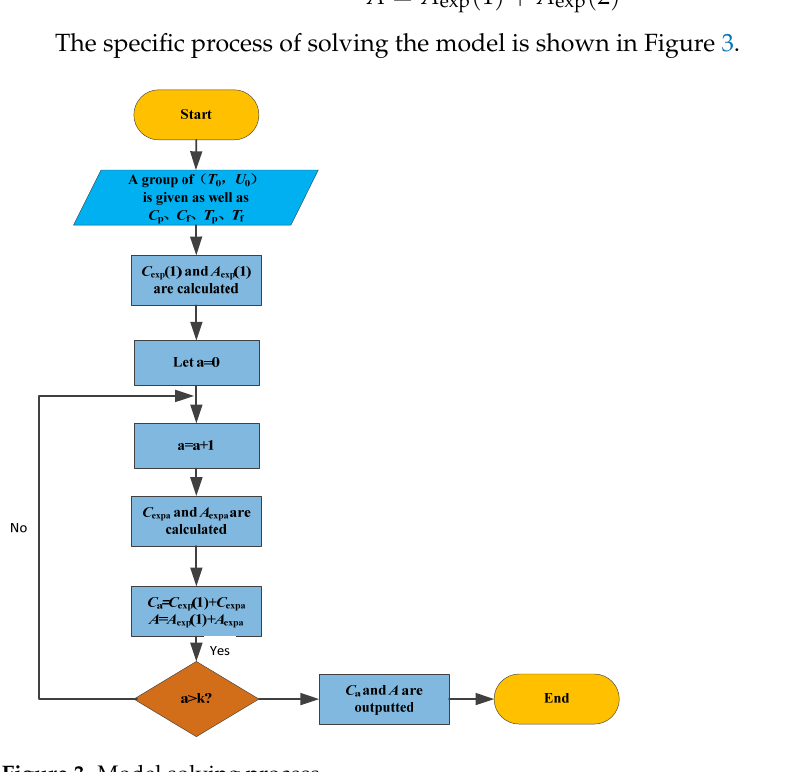
Figure 3. Model solving process.